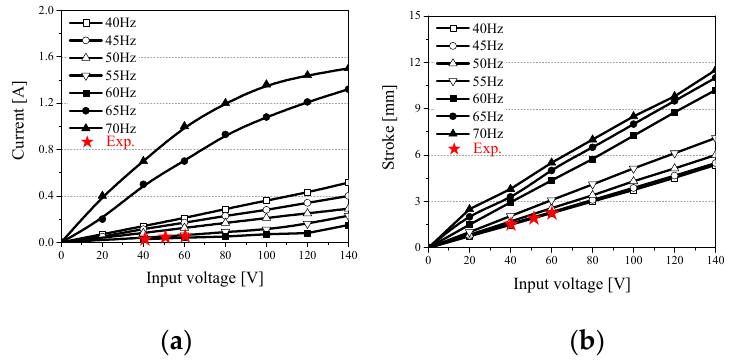
Figure 14. Experiment set of the LOM.